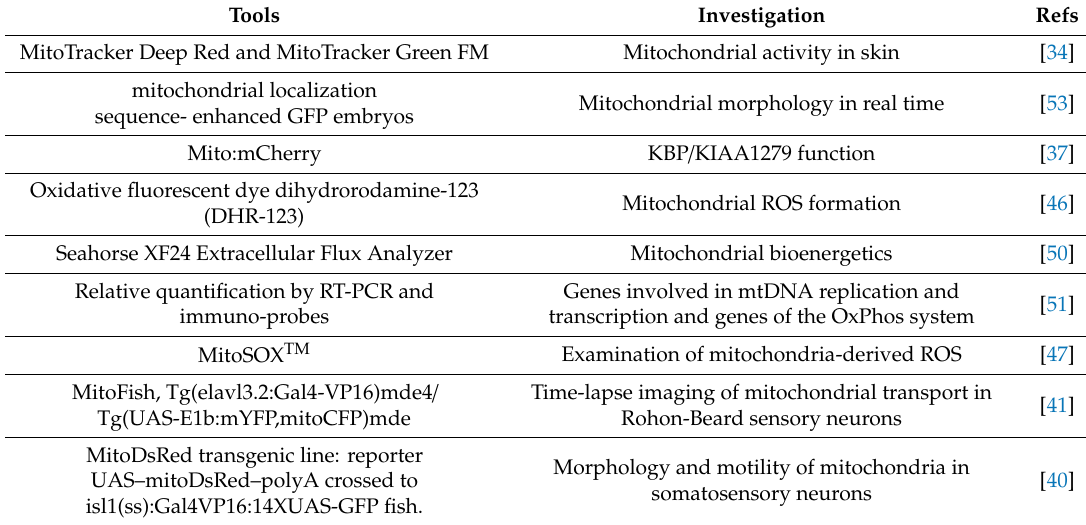
Table 1. Tools used for the investigation of mitochondrial